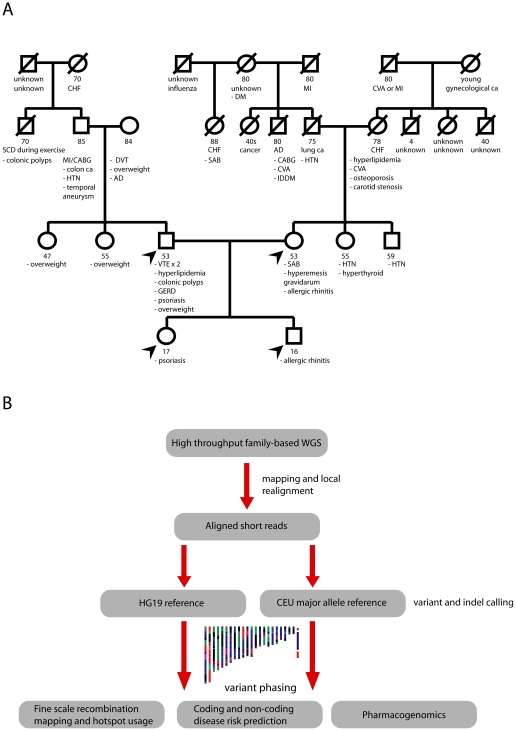
Pedigree and genetic risk prediction workflow.A, Family pedigree with known medical history. The displayed ages represent the age of death for deceased subjects or the age at the time of medical history collection (9/2010) for living family members. Arrows denote sequenced family members. Abbreviations: AD, Alzheimer's disease; CABG, coronary artery bypass graft surgery; CHF, congestive heart failure; CVA, cerebrovascular accident; DM, diabetes mellitus; DVT, deep venous thrombosis; GERD, gastroesophageal reflux disease; HTN, hypertension; IDDM, insulin-dependent diabetes mellitus; MI, myocardial infarction; SAB, spontaneous abortion; SCD, sudden cardiac death. B, Workflow for phased genetic risk evaluation using whole genome sequencing.